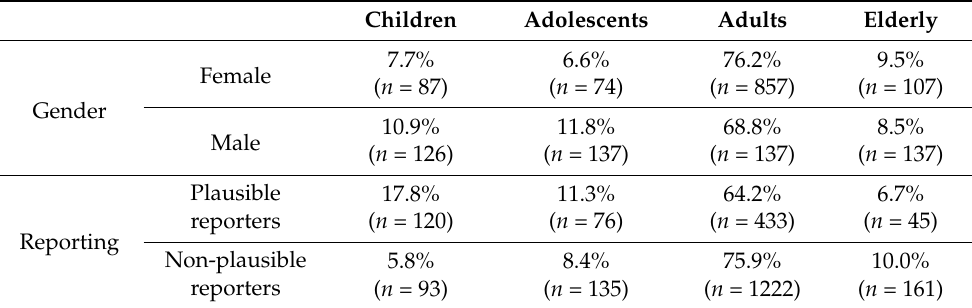
Table 3. Description of the ANIBES sample by gender reporting and age group.